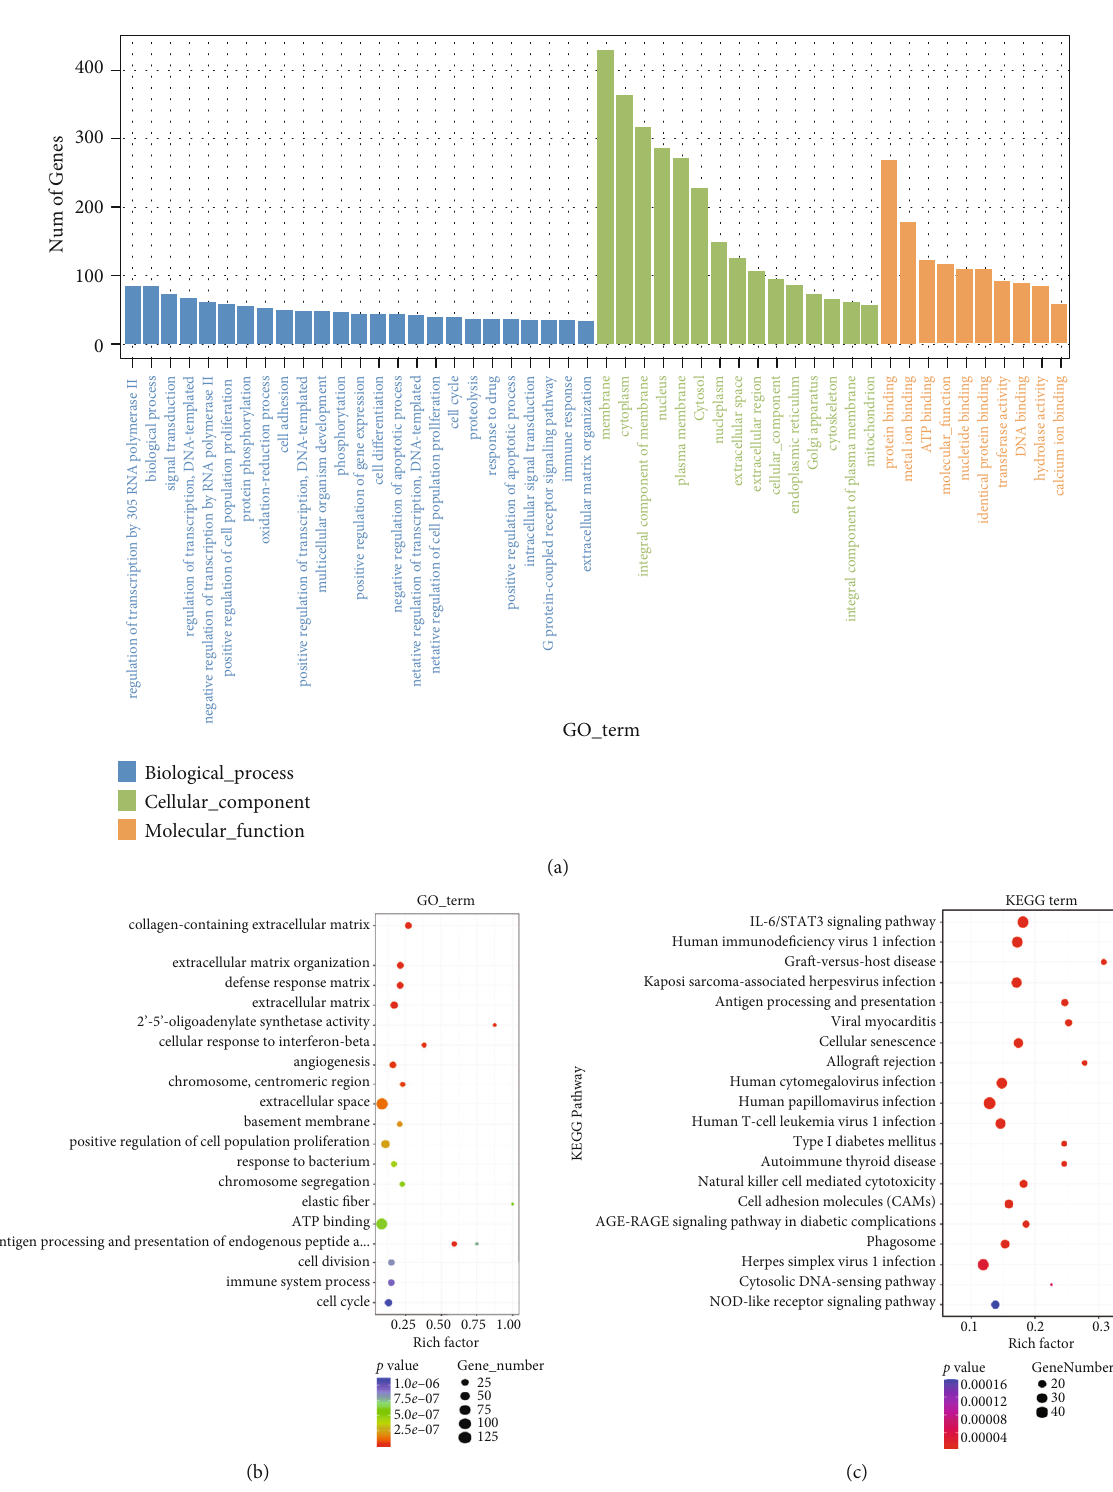
Figure 7: Functional enrichment analysis of the DEGs: (a, b) GO functional enrichment analysis of the DEGs; (c) KEGG pathway enrichment analysis of the DEGs. GO: Gene Ontology; KEGG: Kyoto Encyclopedia of Genes and